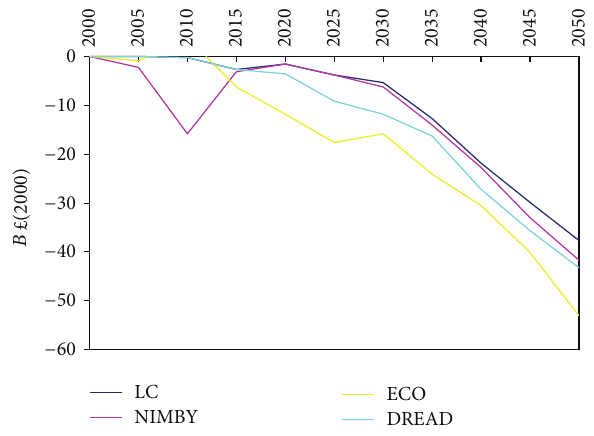
Figure 7: Societal welfare expressed as consumer and producer